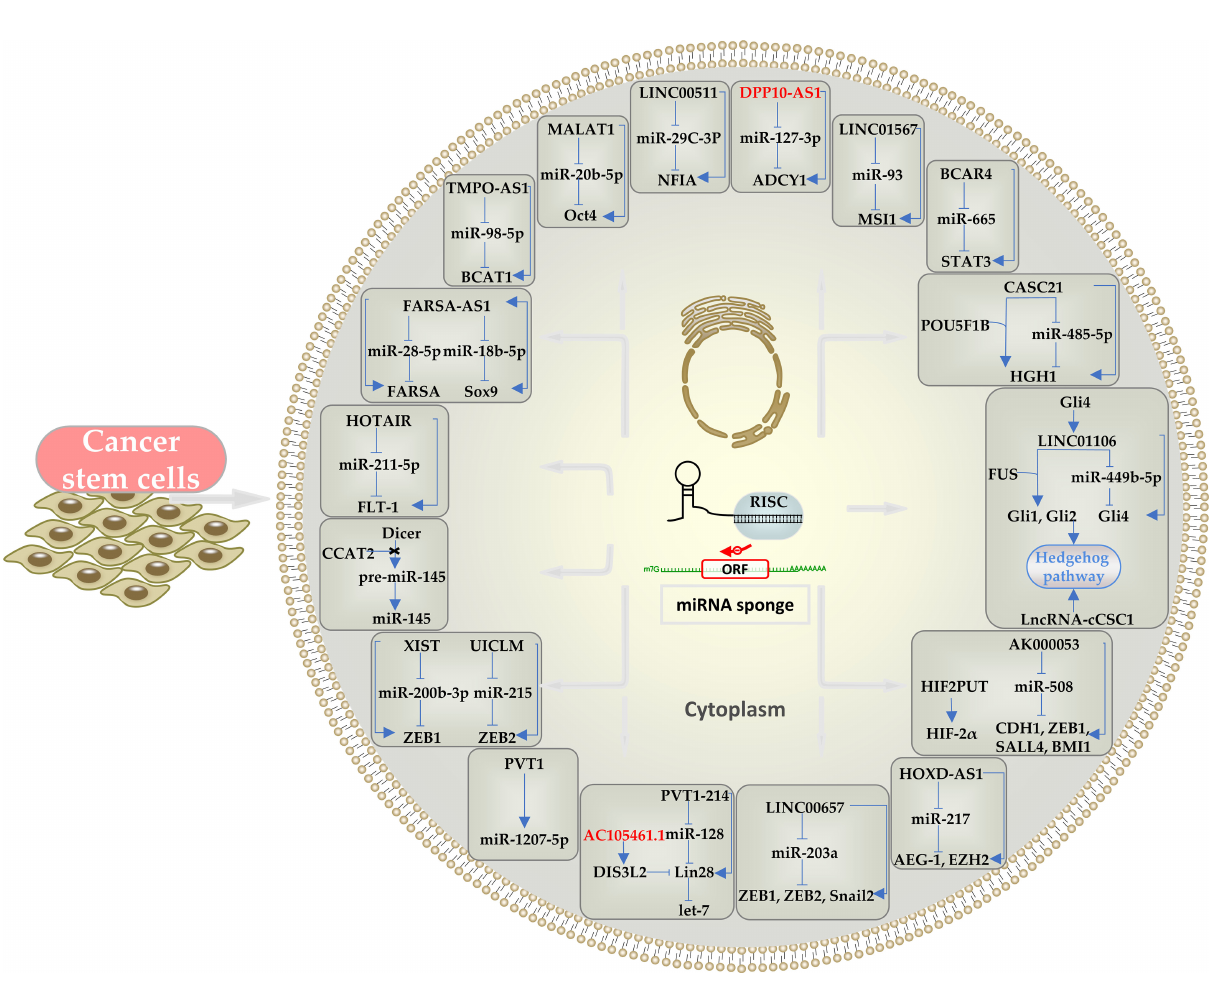
FIGURE 1 | Schematic representation of the effects of cytoplasmic lncRNAs in CRCSCs through ceRNA mechanism and the downstream pathways and mediators involved. LncRNAs can act as a miRNA sponge. Oncogenic lncRNAs are indicated in black and tumor-suppressor lncRNAs in